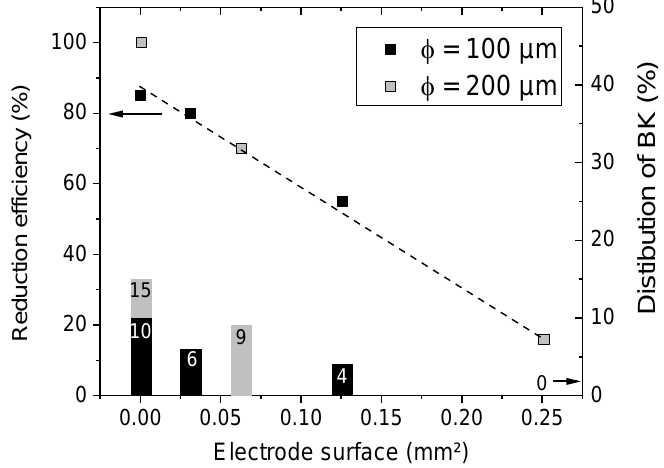
Figure 6. Reduction efficiency (dots) and Distribution of BK (columns) after 120 min according to the electrode surface in contact with the liquid.